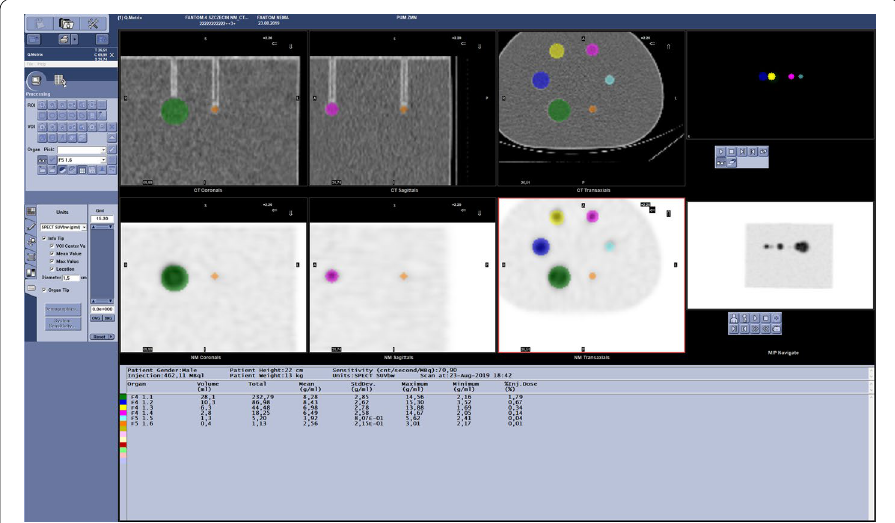
Fig. 2 A screenshot of the Q.Metrix software during the measurement of hot spheres activity in the cross sections of the NEMA/IEC Body Phantom. Color rings correspond to VOI (volume of interest) for 6 hot